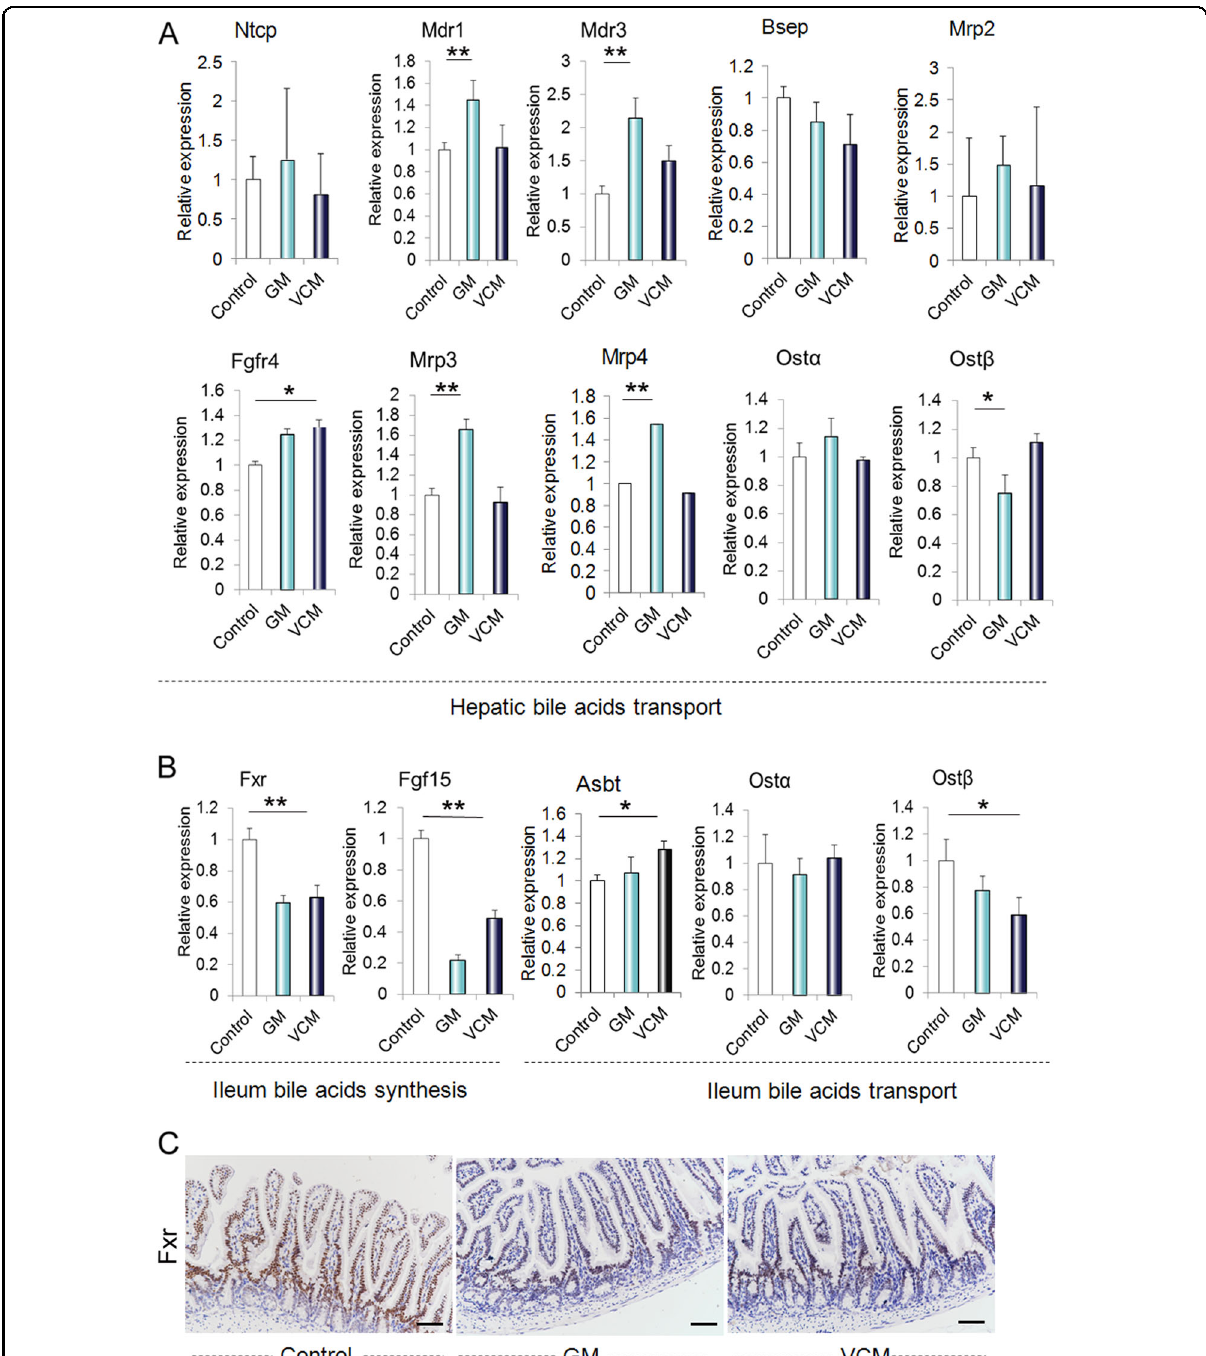
Fig. 5 Analysis of bile acid synthesis and transport pathways in the liver and ileum. a Gene expression changes in bile acid transporters in the liver of untreated and antibiotic-treated animals. b Representative images of Fxr and Cyp7a1 immunohistochemical staining in liver tissues. c Western blot analysis for Fxr and Cyp7a1 in liver tissues. Scale bar = 25 µm; * p < 0.05, ** p <